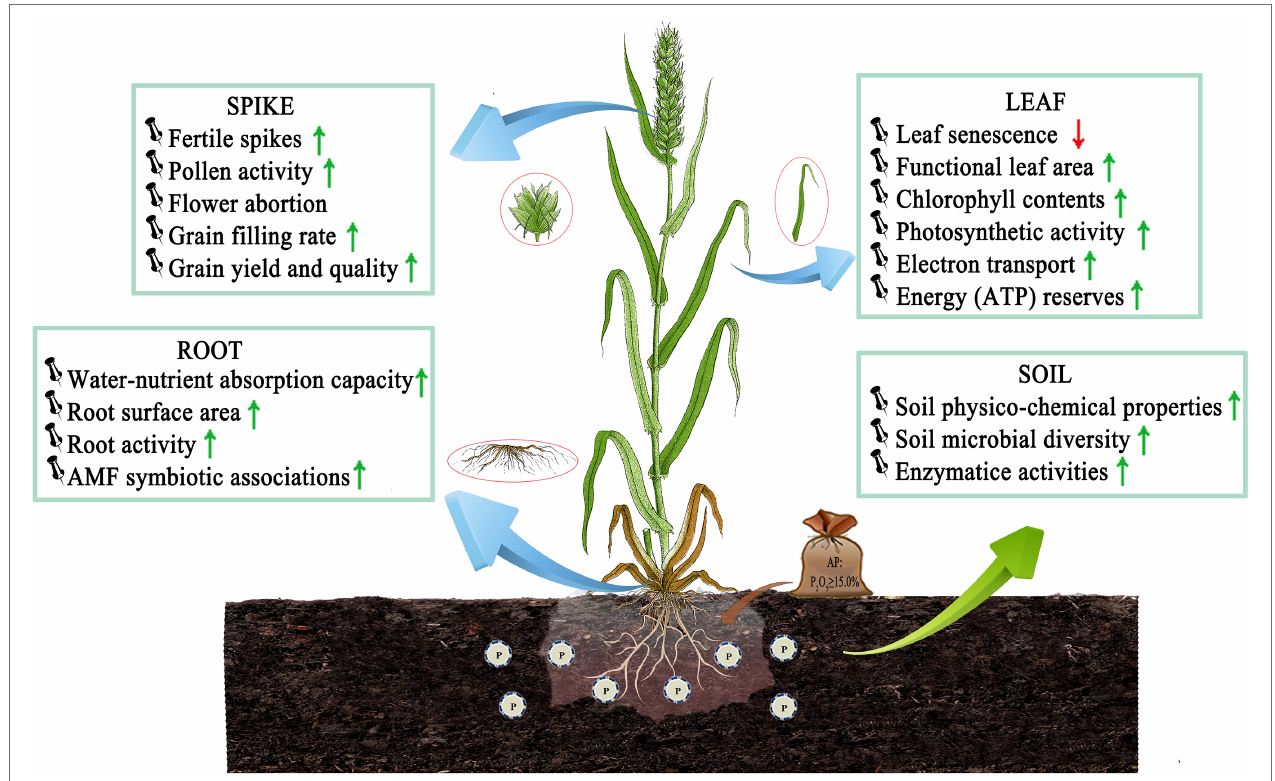
FIGURE 1 | LTS tolerance mechanism by optimizing P application in wheat. Optimizing P application improves soil–plant nutrient relationships, maintains source- sink balance and membrane stability, relieves dehydration and oxidative stress, and enhances crop stress resistance and productivity in wheat. And root surface area and root activity increase in roots; functional leaf area, PS and photoproduct increase in leaves; flower abortion decreases, but pollen activity, grain yield and quality increase in spikes by P application, respectively. AMF: arbuscular mycorrhizal fungi, ATP: adenosine triphosphate [Here, ↓ indicates a decrease and ↑ indicates an